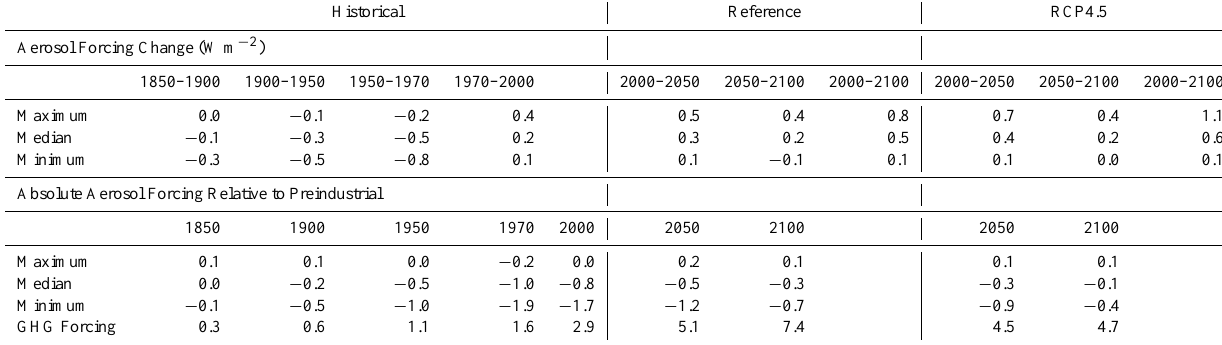
Table 3. Central and range for estimated change in aerosol forcing (SO 2 , BC, OC, cloud indirect) over specific time periods, for the reference and RCP4.5 policy scenarios. Total greenhouse gas forcing in the RCP4.5 scenario (see Fig. 4) is also